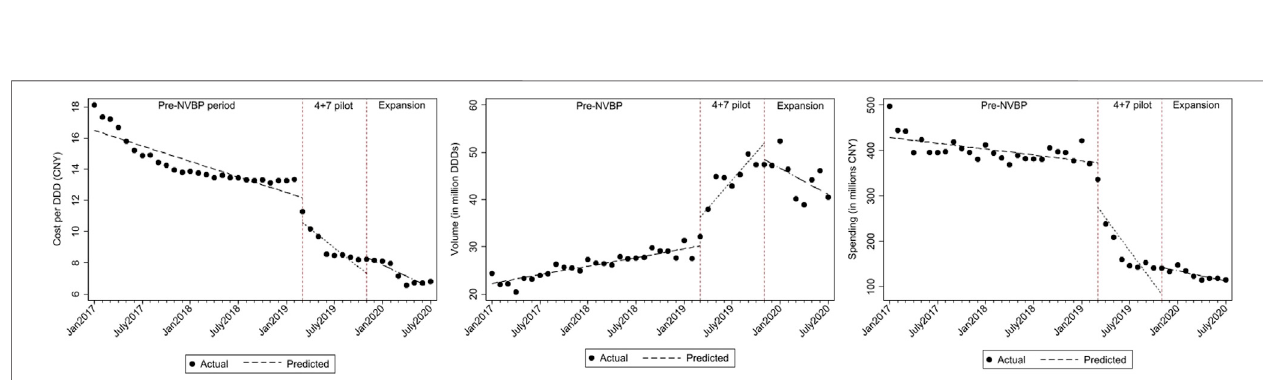
FIGURE3| The observedand predictedoutcomes values fromaggregated ITSanalysisfor (A) cost per DDD (B) procurement volume (C) procurement spending.